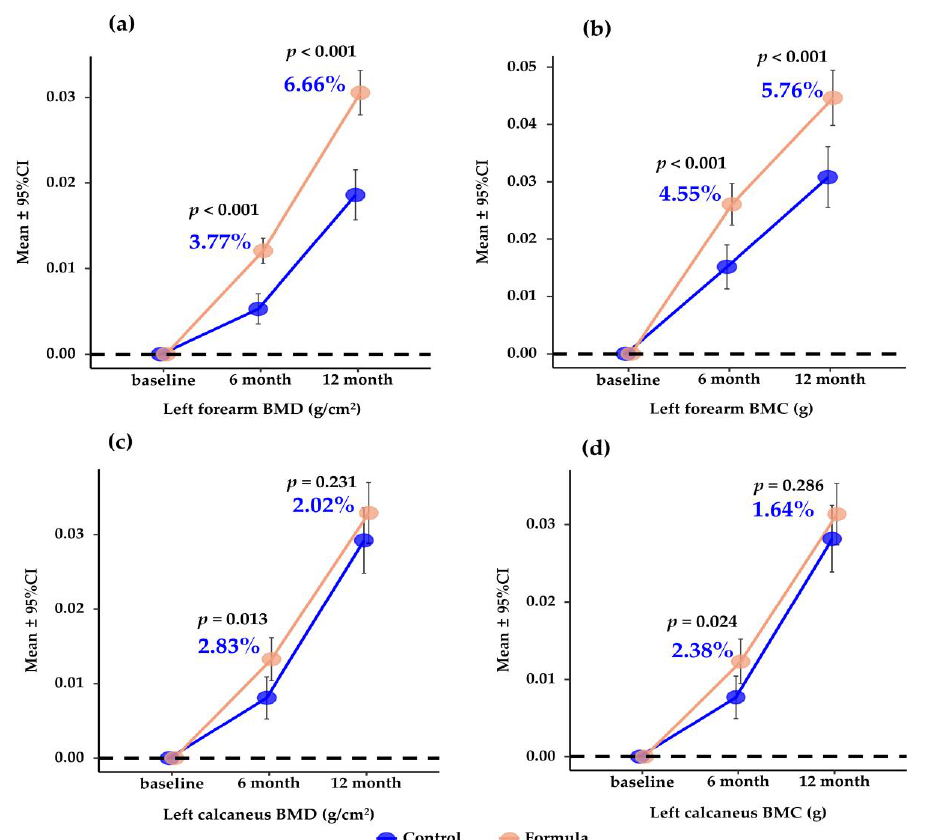
Figure 2. Mean (95%CI) change in BMD and BMC at the left forearm and calcaneus over 6 and 12 months compared to baseline. p values are for the differences between groups by Student’s t -test. Percentages are incremental gains of BMD and BMC. ( a , b ) mean (95%CI) change in BMD ( a ) and BMC ( b ) at the left forearm; ( c , d ), mean (95%CI) change in BMD ( c ) and BMC ( d ) at the left calcaneus; BMD, bone mineral density; BMC, bone mineral content.